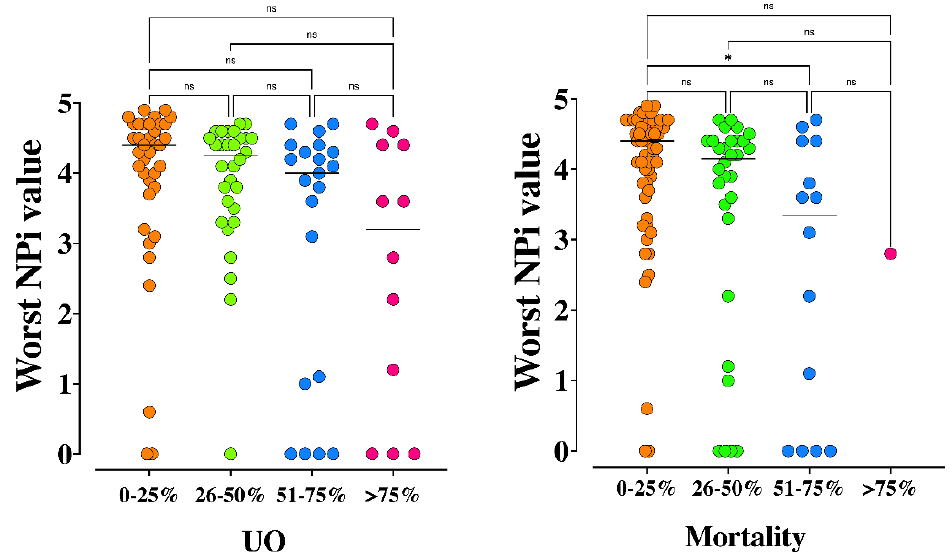
Figure 4. Worst Neurological Pupil Index (NPi) values across different predicted 6-month unfavorable neurological outcome (UO, p = 0.04) and mortality ( p = 0.01) according to the TBI-IMPACT database. * p < 0.05 for post hoc analysis among groups. NS = not statistically significant. The Kruskal Wallis test, with Dunn-Bonferroni post hoc analysis, was used.